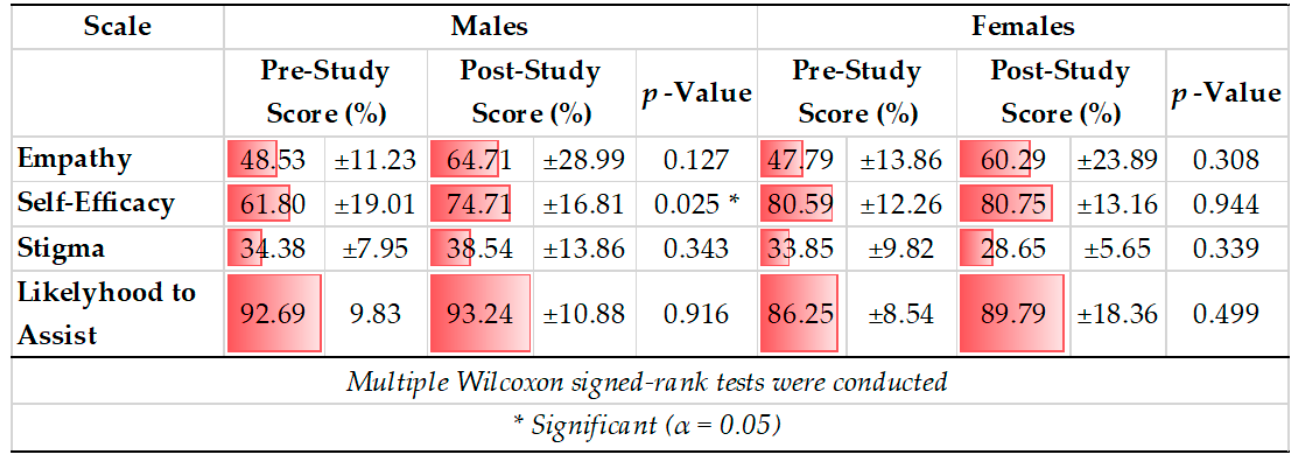
Table 3. Pre- vs. Post-Study Survey Score Comparison for All 4 Scales within Males and